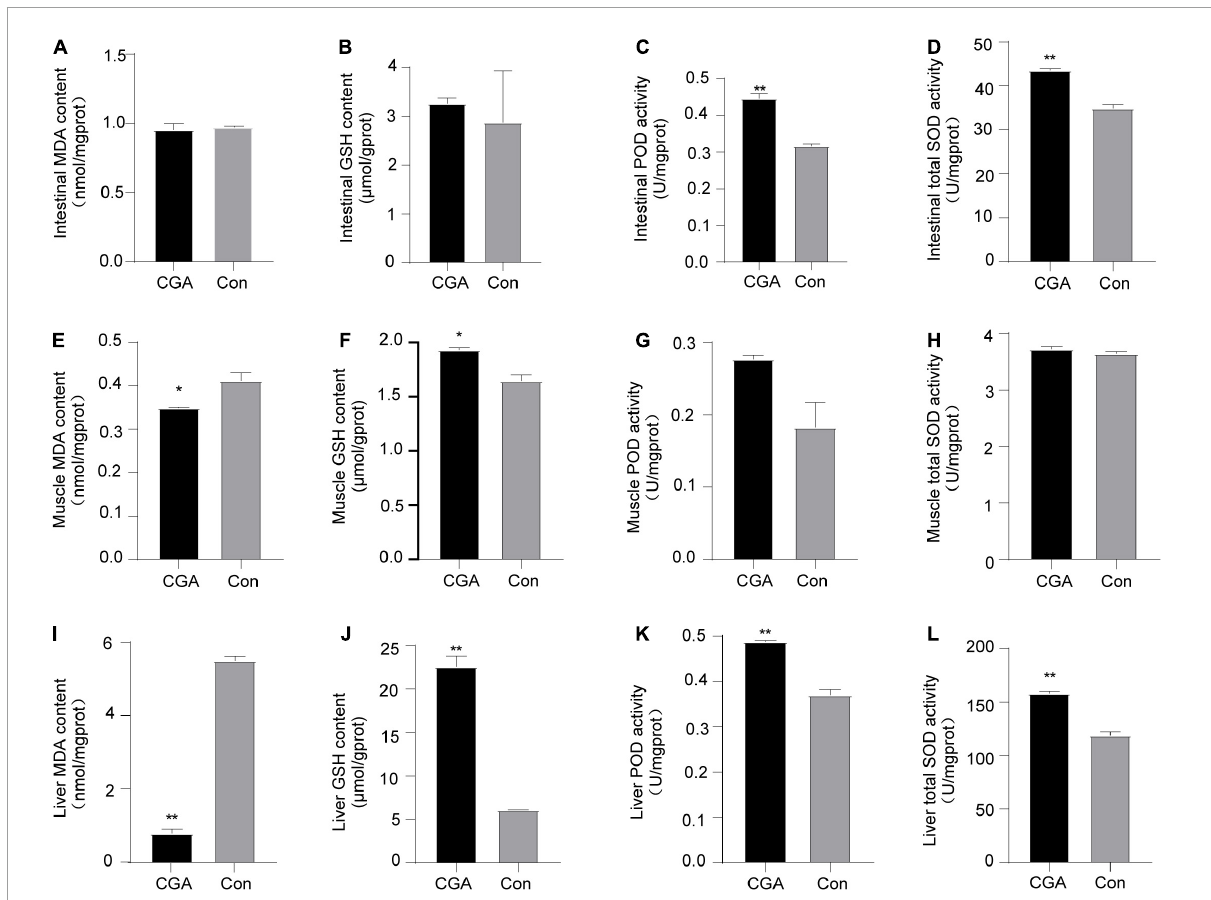
FIGURE5 Effect of chlorogenic acid (CGA) on antioxidant capacity of intestinal, muscle, and liver of Carassius auratus . (A) Malondialdehyde (MDA) content in intestinal tissue. (B) Glutathione (GSH) activity in intestinal tissue. (C) Peroxidase (POD) content in intestinal tissue. (D) Superoxide dismutase (SOD) activity in intestinal tissue. (E) MDA content in muscle tissue. (F) GSH activity in muscle tissue. (G) POD content in muscle tissue. (H) SOD activity in muscle tissue. (I) MDA content in liver tissue. (J) GSH activity in liver tissue. (K) POD content in liver tissue. (L) SOD activity in liver tissue. Malondialdehyde (MDA), glutathione (GSH), peroxidase (POD), and superoxide dismutase (SOD). *Indicates a significant difference compared to the control group ( P < 0.05); **Indicates a significant difference compared with the control group ( P < 0.01). The acronym for the CGA-added group is CGA and the acronym for the control group is Con.